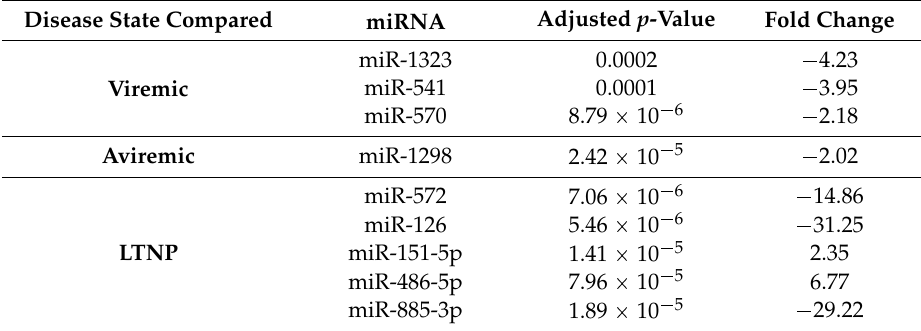
Table 5. DE miRNAs in CD8+ T-cell disease groups compared to HIV– controls. Disease State Compared miRNA